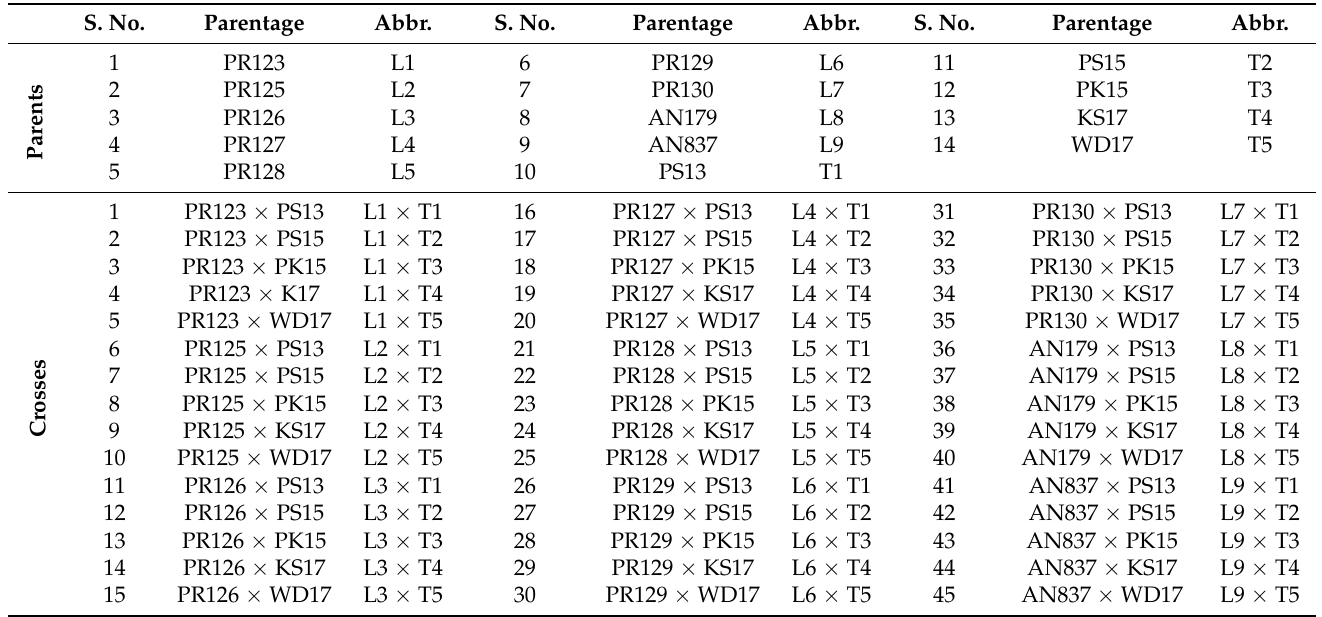
Table 1. List of wheat breeding material i.e., lines (L), testers (T) and their crosses. S.